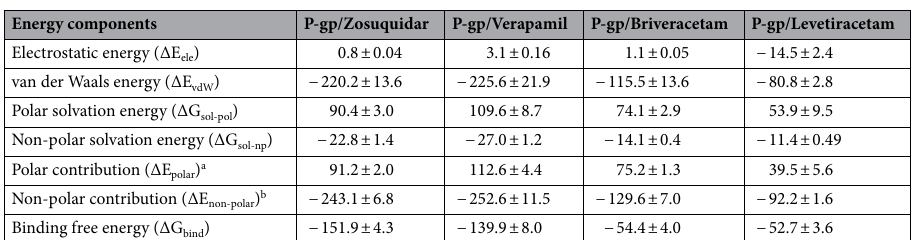
Table 1. The computed binding free energy and contribution of the energy elements (kJ/mol). a